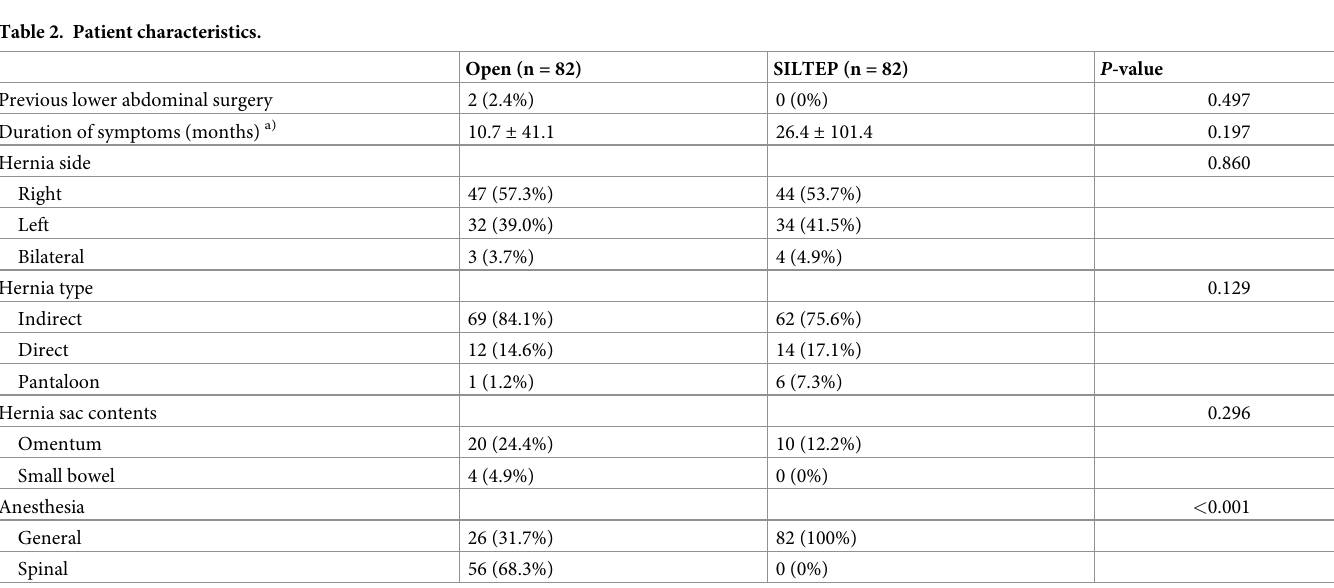
Values are indicated as number (percentage) unless indicated otherwise; a) values are indicated as mean ± standard